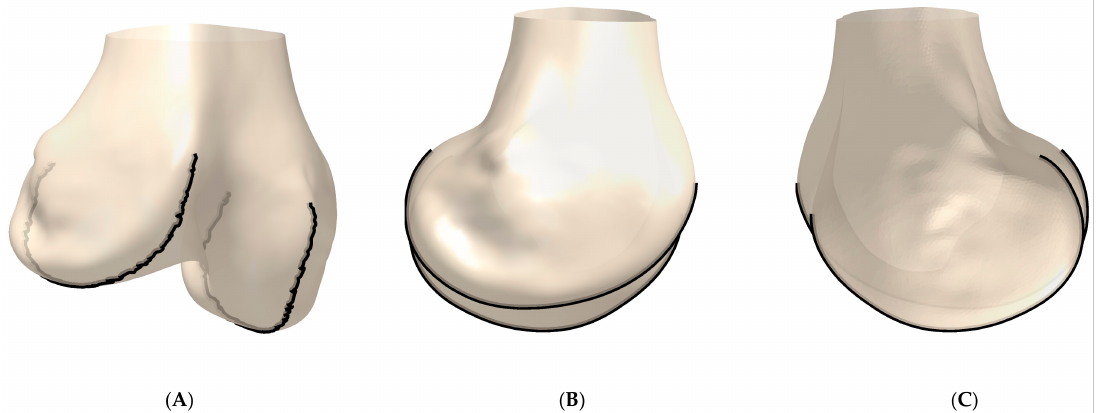
Figure 3. Example of the derived 3D J-Curve contours. ( A ) Anterior/lateral-posterior/medial view. ( B ) Lateral-medial view. ( C ) Medial-lateral view.